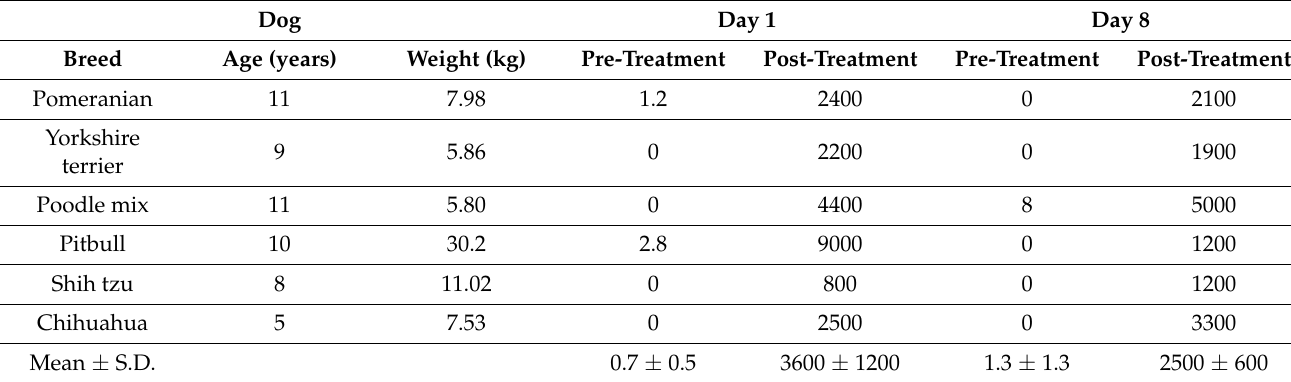
Table 6. An 8-day repeat-dose study of AFPep blood levels in dogs (in ng/mL) a .